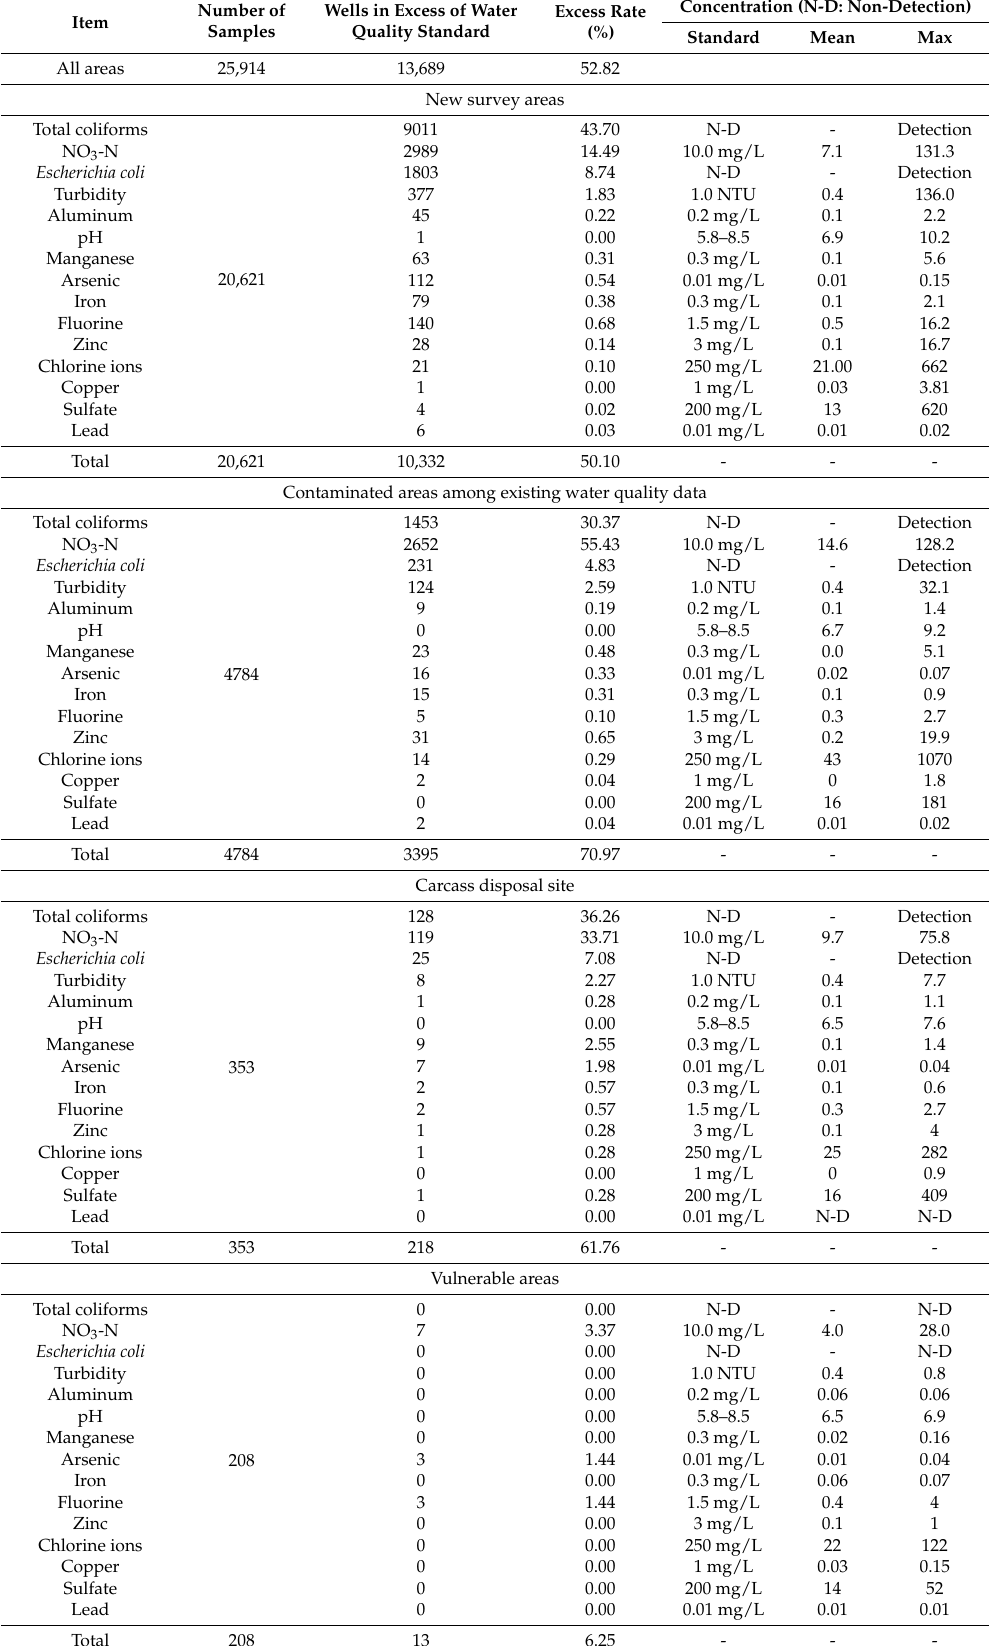
Table 9. Results of water quality analysis with 15 items in